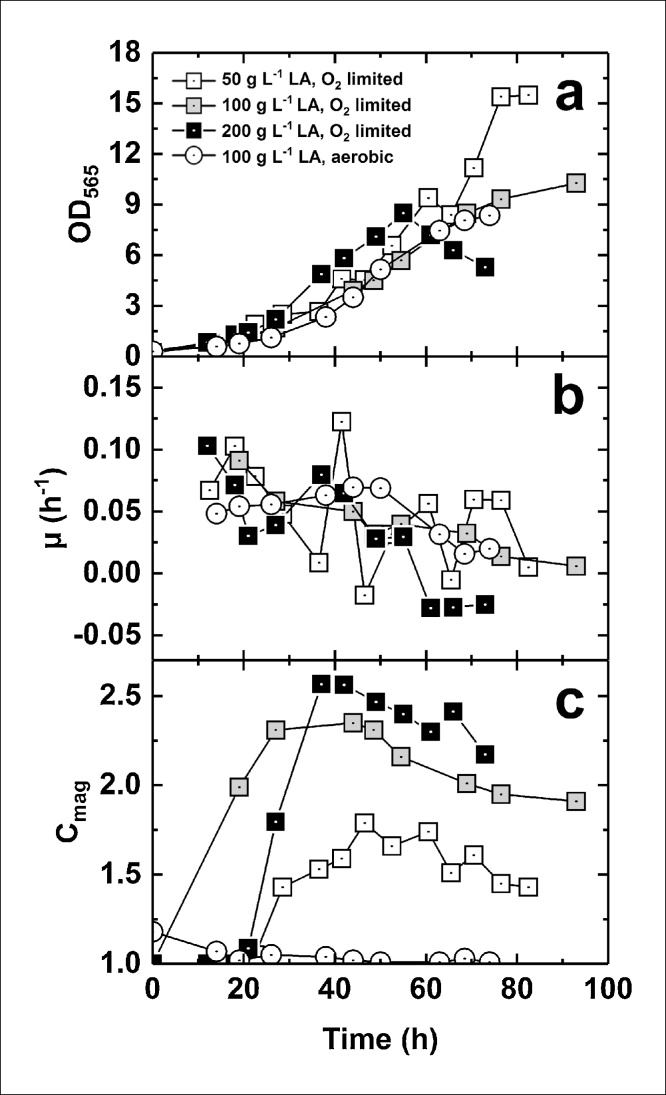
Comparison of oxygen-limited and aerobic fermentations conducted with different feed lactic acid concentrations. Plots show (a) OD565, (b) specific growth rate, μ, and (c) cellular magnetic response, Cmag versus time.